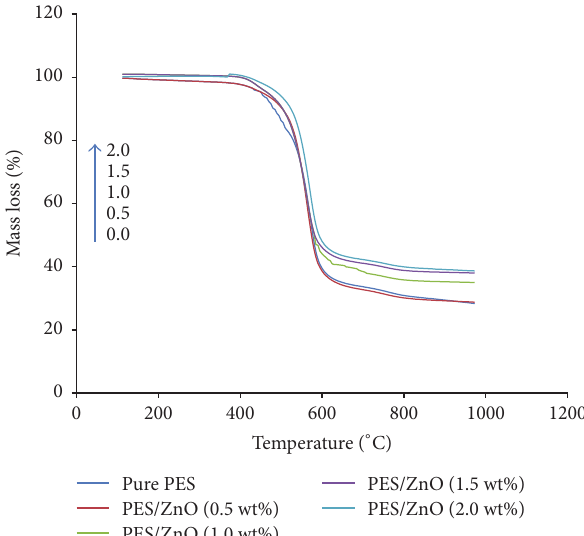
Figure5:TGAresultsforincreasingdecompositiontemperaturefor (0.0, 0.5, 1.0, 1.5, and 2.0 wt%) of ZnO on PES membranes.